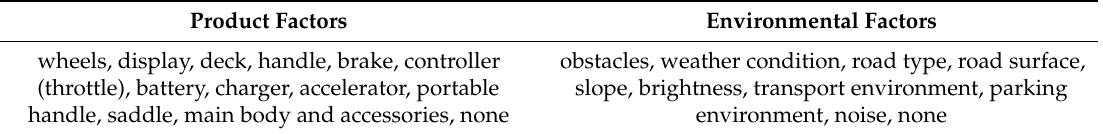
Table 1. List of product factors.